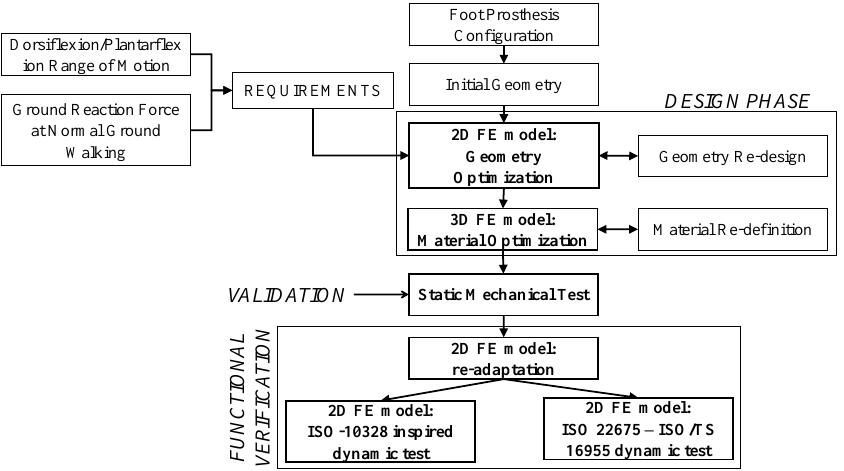
Figure 3. Flowchart of the design methodology: design phase , validation phase and functional verifica- tion phase